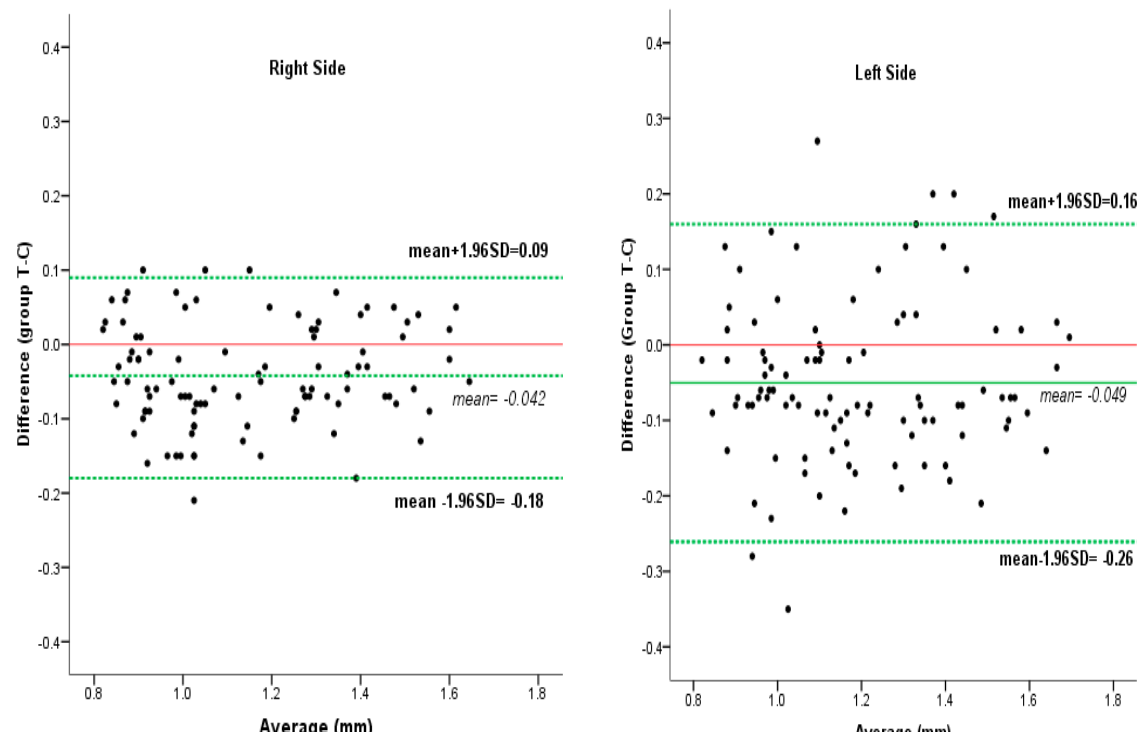
Figure 5. Bland–Altman plot showing the measurement agreement between